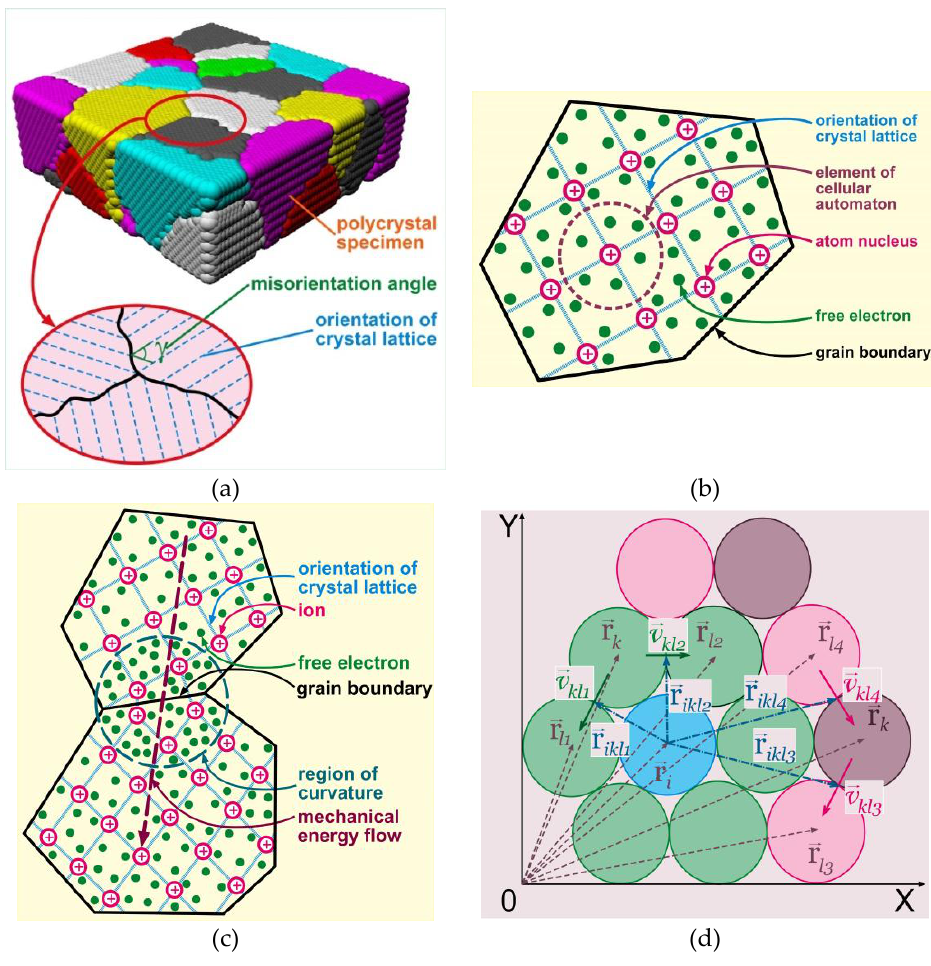
Figure 1. Schematic illustrations: ( a ) polycrystalline specimen as a cellular automaton; ( b ) grains with crystal lattice; ( c ) neighboring grains with different lattice orientations; ( d ) calculation scheme for the angular velocity of material microrotation in the active element of the cellular automaton.